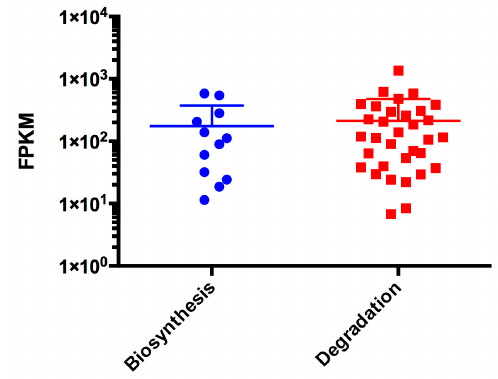
Figure 5. Transcriptional landscape of C. gattii R265 genes associated to valine, leucine, and isoleucine metabolism during pulmonary infection. FPKM values were determined from reads aligned to C. gattii R265 genome using Cufflinks software. Genes associated with biosynthesis (blues dots) and degradation (red squares) processes were recovered from The FungiDB.